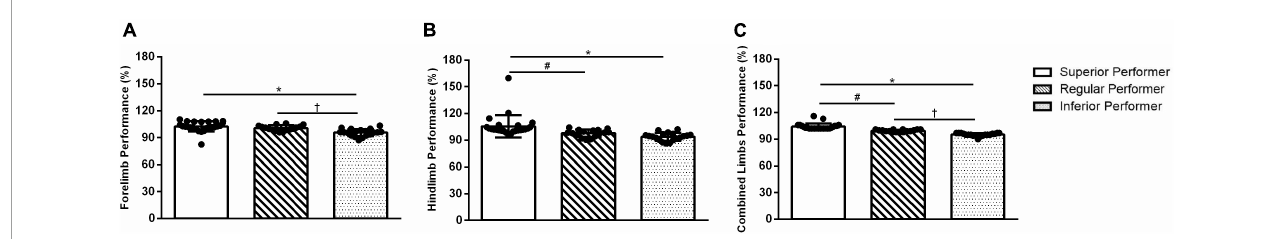
FIGURE1 Walking adaptability performance in the ladder walking test. (A) Forelimb performance, (B) hindlimb performance, and (C) combined limbs performance. Data are expressed as mean ± SD. One-way ANOVA and Tukey’s post-hoc tests were used. *Superior performers vs. inferior performers; # superior performers vs. regular performers; † regular performers vs. inferior performers.